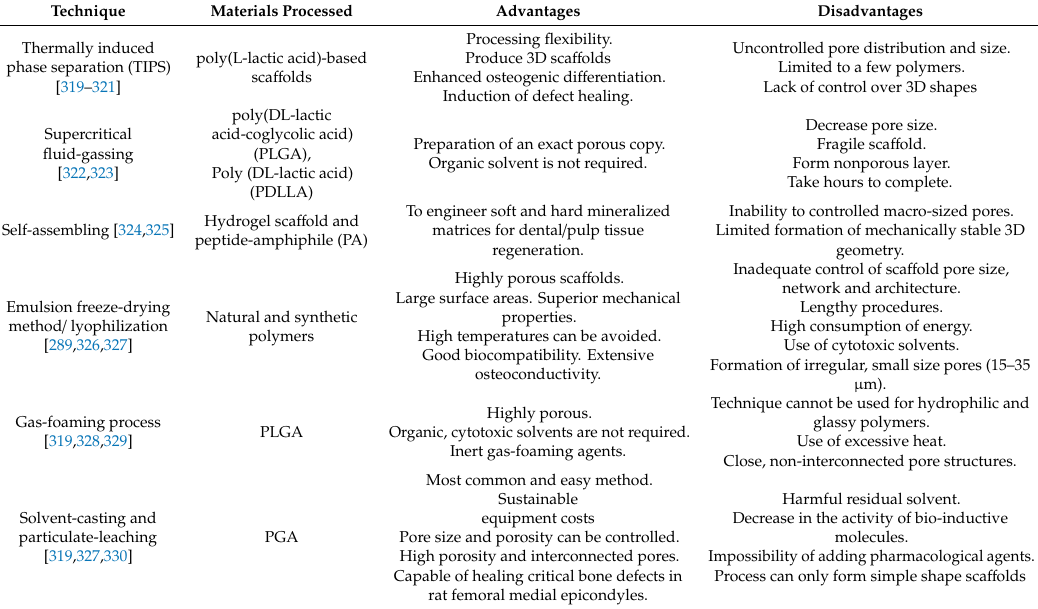
Table 5. Summary of the materials processed, advantages and disadvantages of porogens in biomaterials for biomimetic sca ff old